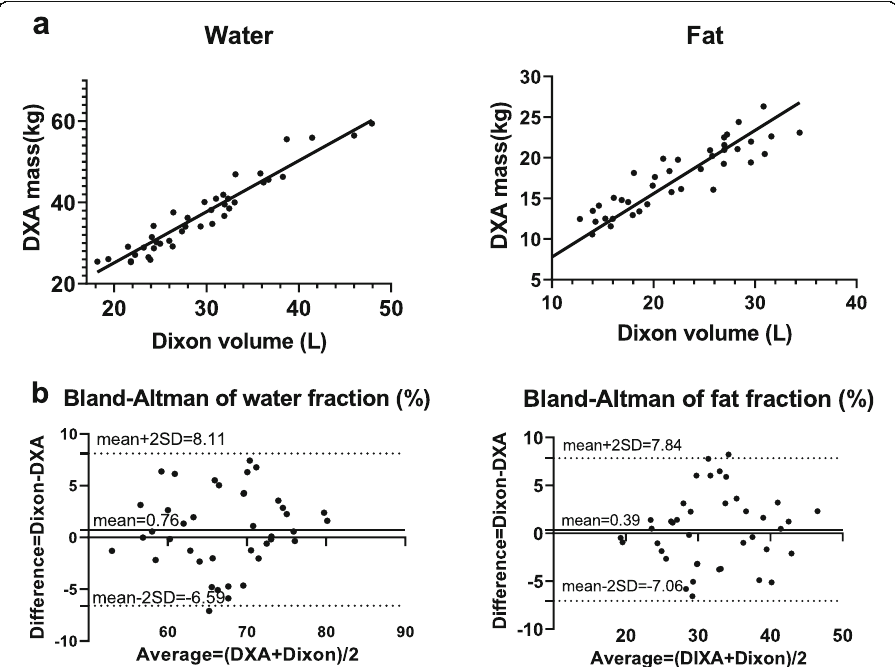
Fig. 4 a Linear regression of volume measured by Dixon MRI vs. mass measured by DXA from head to upper thigh. The solid line represents the linear fit of the data. b Bland-Altman plot showing agreement between fat mass/bodyweight of the DXA and Dixon measurements, and water mass/bodyweight of the DXA and Dixon